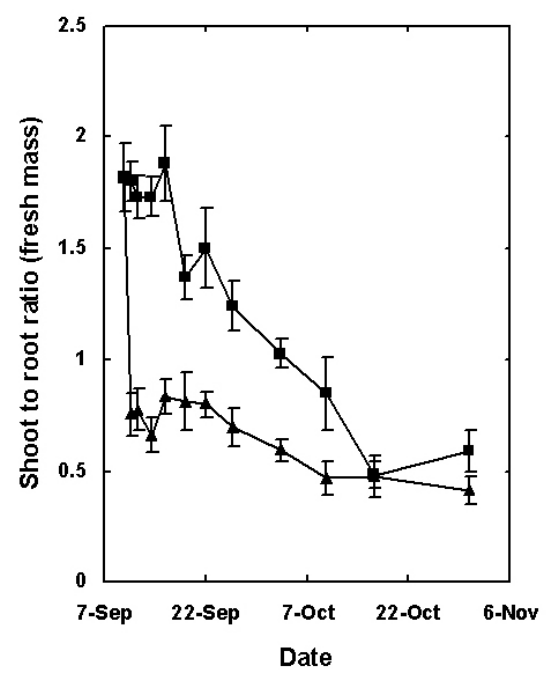
FIGURE 1 . Changes of the shoot to root ratio (g fm) in control ( ■ ) and defoliated ( ▲ ) field-grown chicory plants. high DP fructan (DP > 20) concentrations became higher and lower, respectively while the DP3- 20 relative fructan concentration remained the same (data not shown). Starting from the end of September, both the absolute as well as the relative concentrations of fructan lacking terminal series containing the inulo- n -ose series)[17,25] were much higher in the roots of the glucose (F n defoliated plants than in the control plants (Fig.